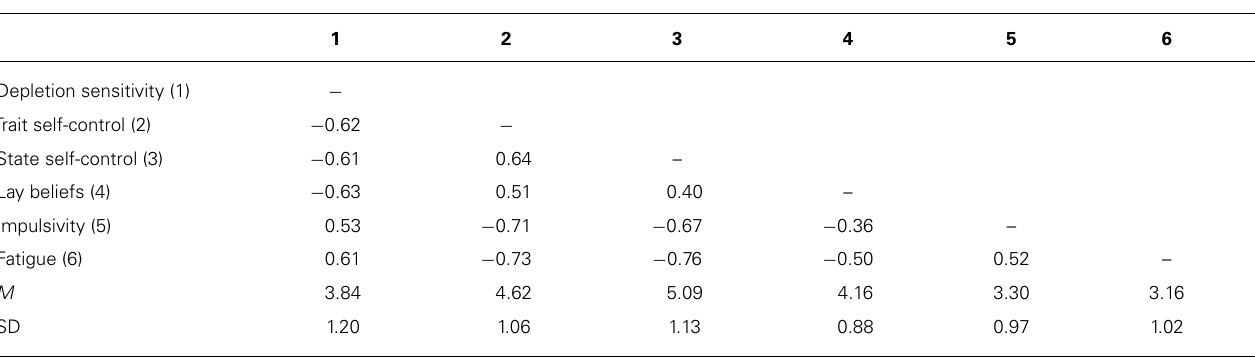
Table 3 | Means, SD and correlations of the DSS with related scales, Study